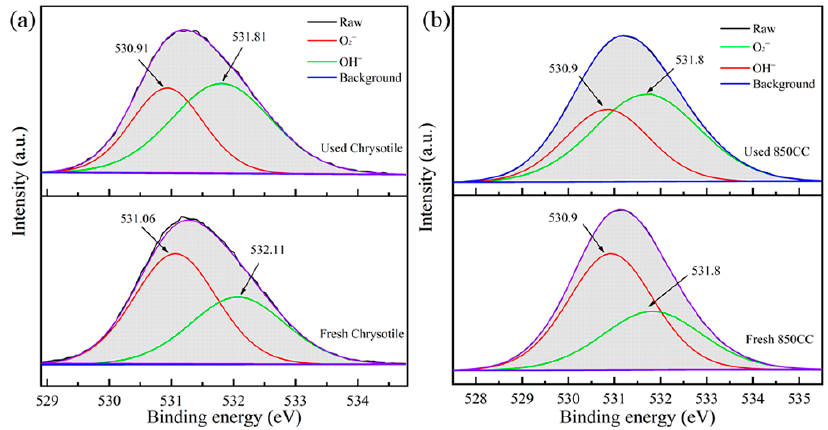
Figure 9. XPS spectra of O 1s for chrysotile ( a ) and 850CC ( b ) before and after catalytic degradation.